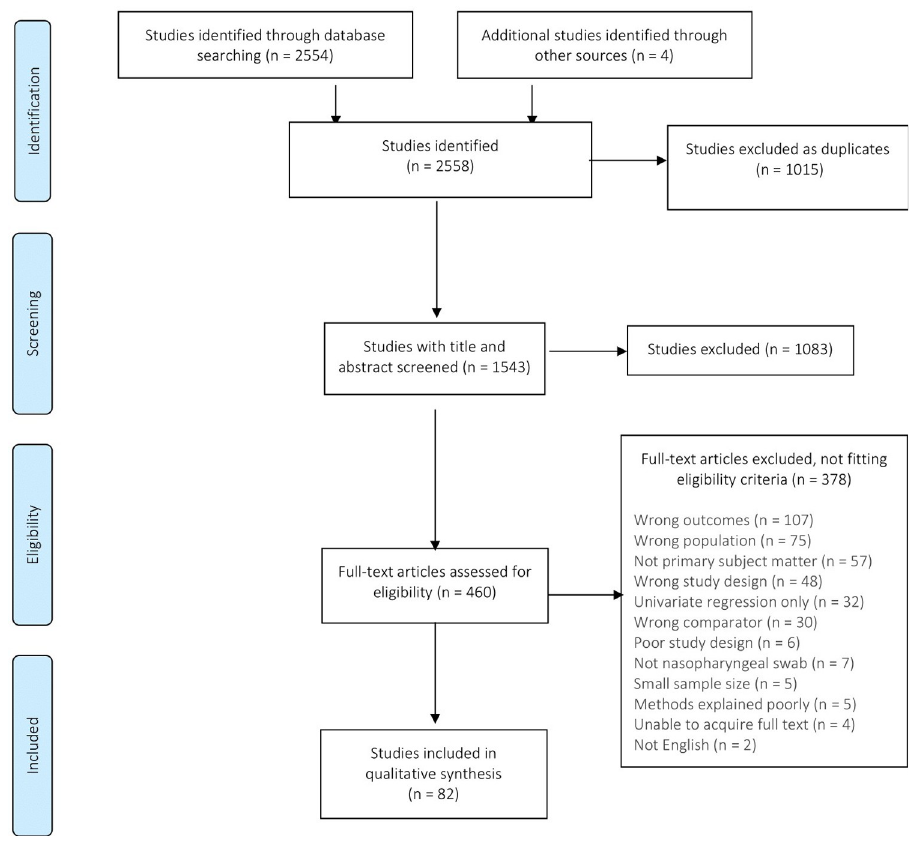
Fig 1. PRISMA flow diagram for study